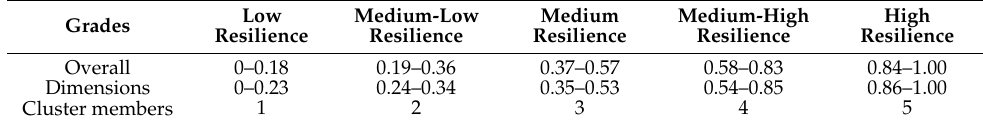
Table 3. Resilience grades and corresponding cluster members.